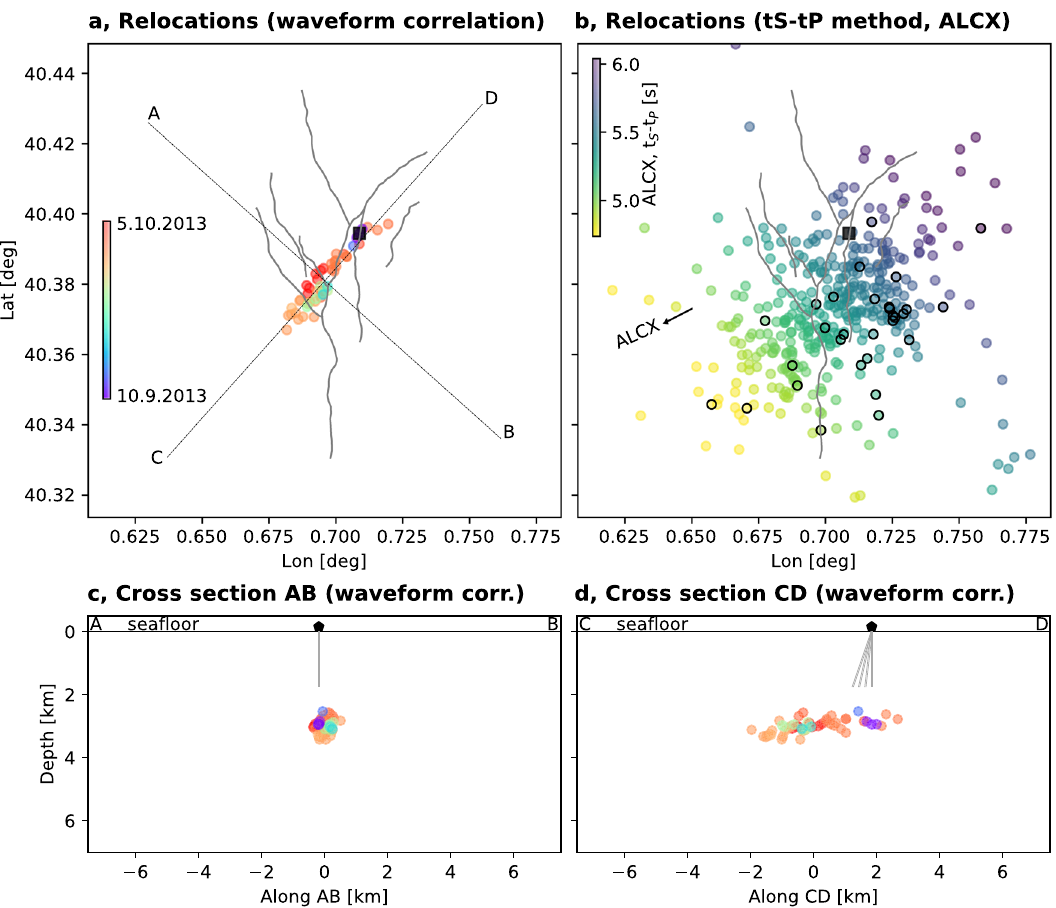
Fig. 2 Locations based on waveform correlations and t S - t P method. a , c , d Locations based on waveform correlations in map view and cross-section. b Locations based on t S - t P method in cross-section. Earthquake locations (circle, colors denoting origin time in a , c , d , and S-P differential time at station ALCX in b , according to color bars in a and b , respectively) are plotted in map view ( a , b ) and along AB ( c ) and CD ( d ) cross-sections (pro fi les AB and CD are shown in a ). Black circles in b denote those events used in the waveform correlation location ( a ), for which S-P time estimates are available. A pentagon denotes the location of the Castor platform, double gray solid lines sketch the injection wells 29